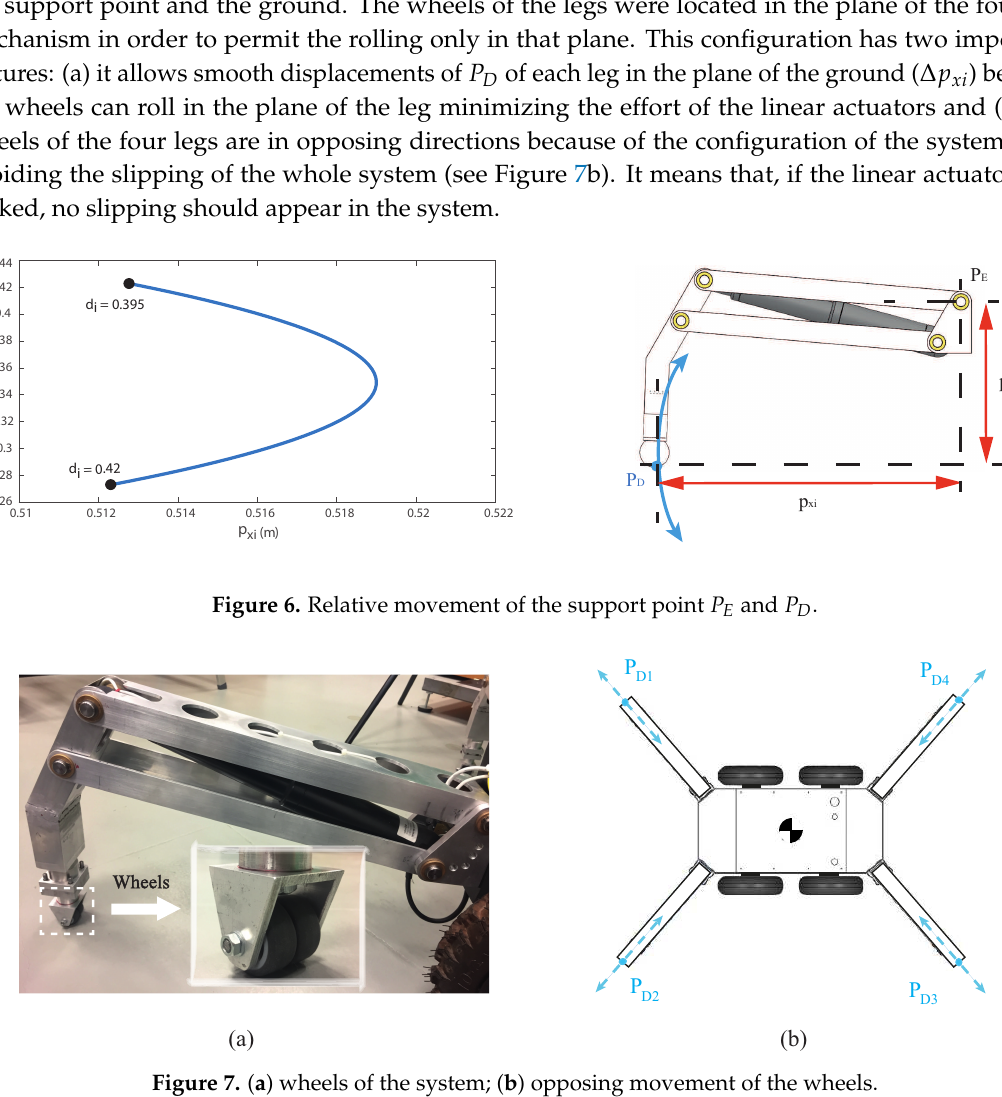
Figure 7. ( a ) wheels of the system; ( b ) opposing movement of the